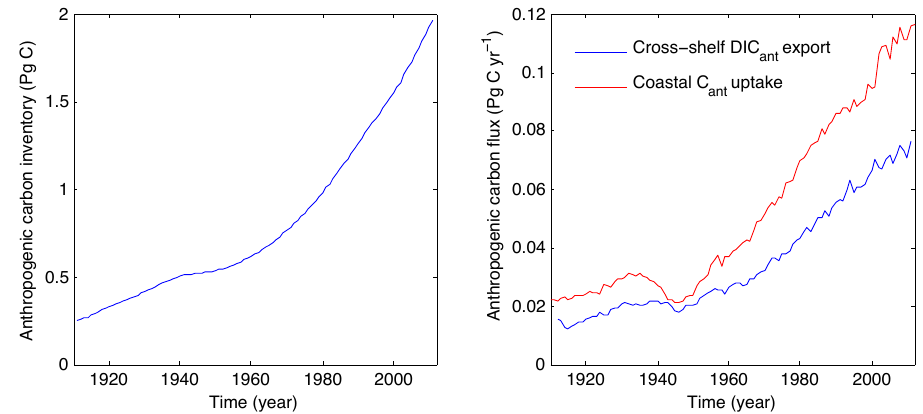
Figure 10. Simulated temporal evolution of (a) coastal-ocean inventory of anthropogenic carbon given in PgC and (b) anthropogenic CO 2 (C ant ) uptake by the global coastal ocean and global cross-shelf export of anthropogenic carbon (DIC ant ) given in PgCyr − 1